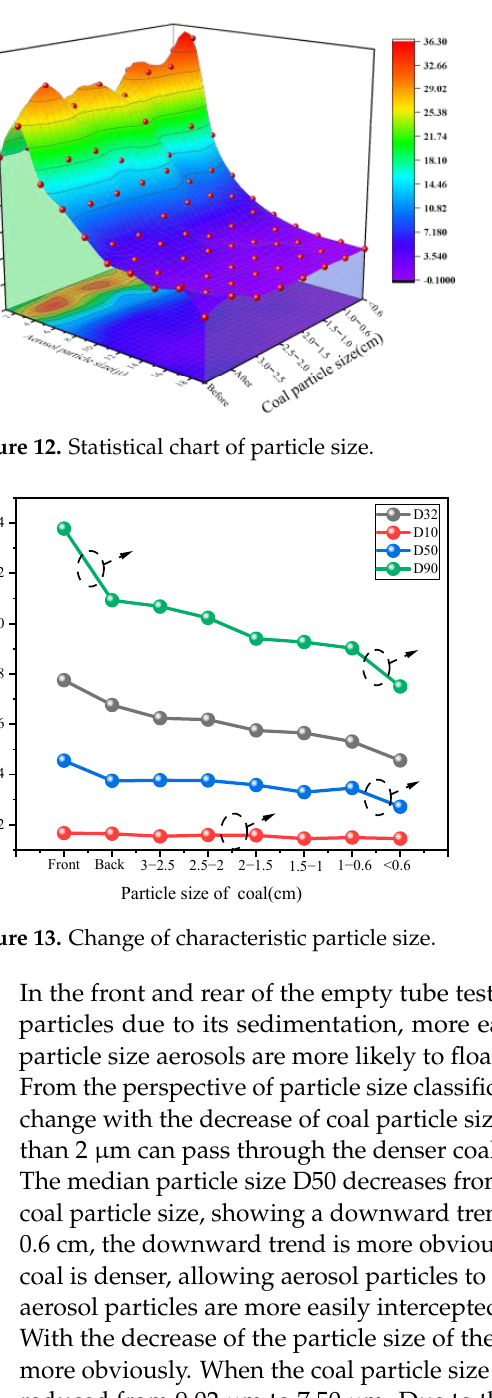
( h )<0.6 cm Figure 11. Aerosol particle size distribution under different void structures. ( a ) is the droplet at the